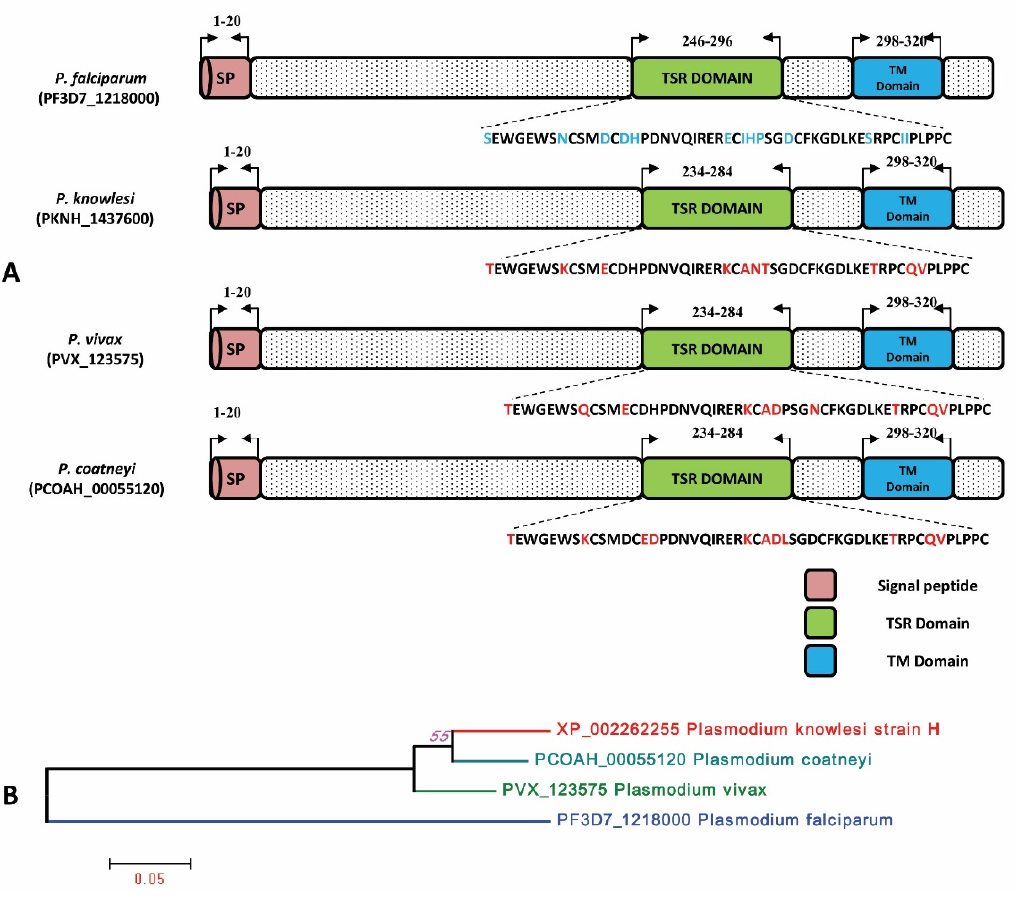
Figure 2. ( A ) Schematic structure of TRAMP gene in P. falciparum, P. knowlesi , P. vivax and P. coatneyi . The Signal peptide, TSR and TM domain have been marked by the arrows with their sequence positions. The amino acid polymorphisms in the TSR domain within three Plasmodium sp. are highlighted in red in comparison to P. falciparum . SP: Signal peptide, TSR: Thrombospondin type-1 repeat super family, TM: Transmembrane. ( B ) Phylogenetic tree of TRAMP gene constructed using MEGA 5.0 by ML method shows inter-species relation between P. knowlesi , P. coatneyi , P. vivax and P. falciparum .